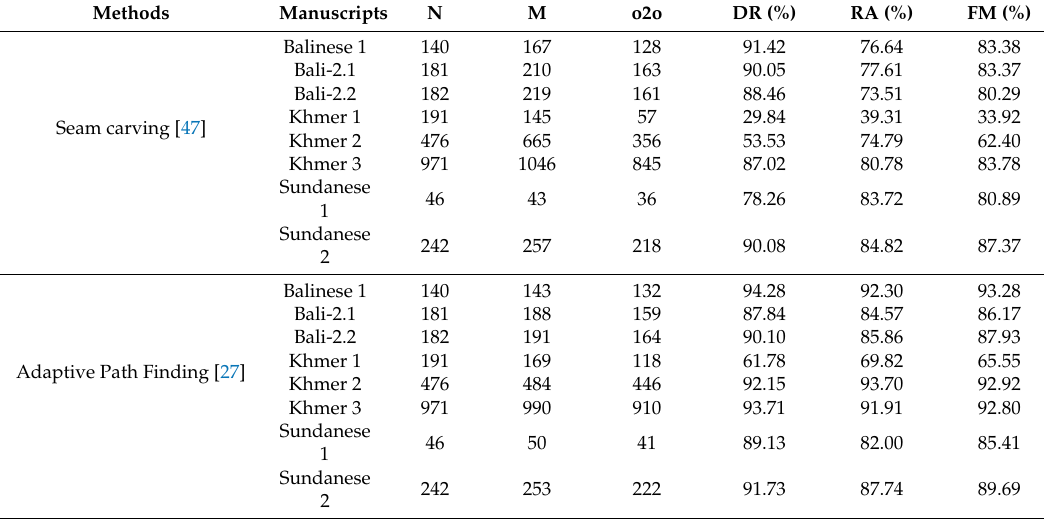
Table 6. Experimental results for text line segmentation task: the count of ground truth elements (N), and the count of result elements (M), the one-to-one (o2o) match score is computed for a region pair based on 90% acceptance threshold, detection rate (DR), recognition accuracy (RA), and performance metric (FM).